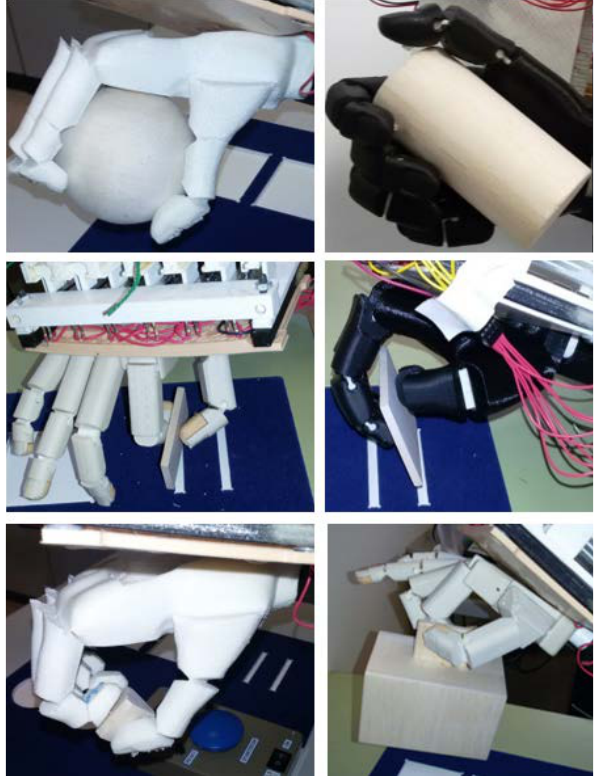
Figure 7. Tested hands performing SHAP’s LAO tasks. The six objects of the LAO set are shown. Three able-bodied subjects participated in this experiment. The order of the devices as they were fastened to the ABA to be tested consecutively by the three subjects was: Lb- 45, Dextrus, Lb-0, and IMMA. According to the SHAP manual, subjects sat at a table with their arms resting on the table and elbows at almost 90° angle, and the SHAP kit was placed right in front. Task instructions were given before each task with the LAO. The tasks were self-timed: the subject started each task seated, with the prosthetic hand open, and pressed a chronometer before and after each task to record the time it took. The scoring system used adapts the Linear Index Function (LIF) [56] to the LAO set, with proven equivalent results to the SHAP’s original system [35], namely: 𝐿𝐿𝐿𝐿𝐿𝐿 𝐿𝐿𝐿𝐿𝐿𝐿 = 1 6 · � 𝑇𝑇 𝑠𝑠 𝑙𝑙 6 𝑙𝑙=1 (1) In the expression (1), 𝑇𝑇 𝑠𝑠𝑙𝑙 is the Transformed Time Score registered for each of the SHAP tasks with LAO achieved within 𝑡𝑡 seconds, and it is calculated as a percentage of